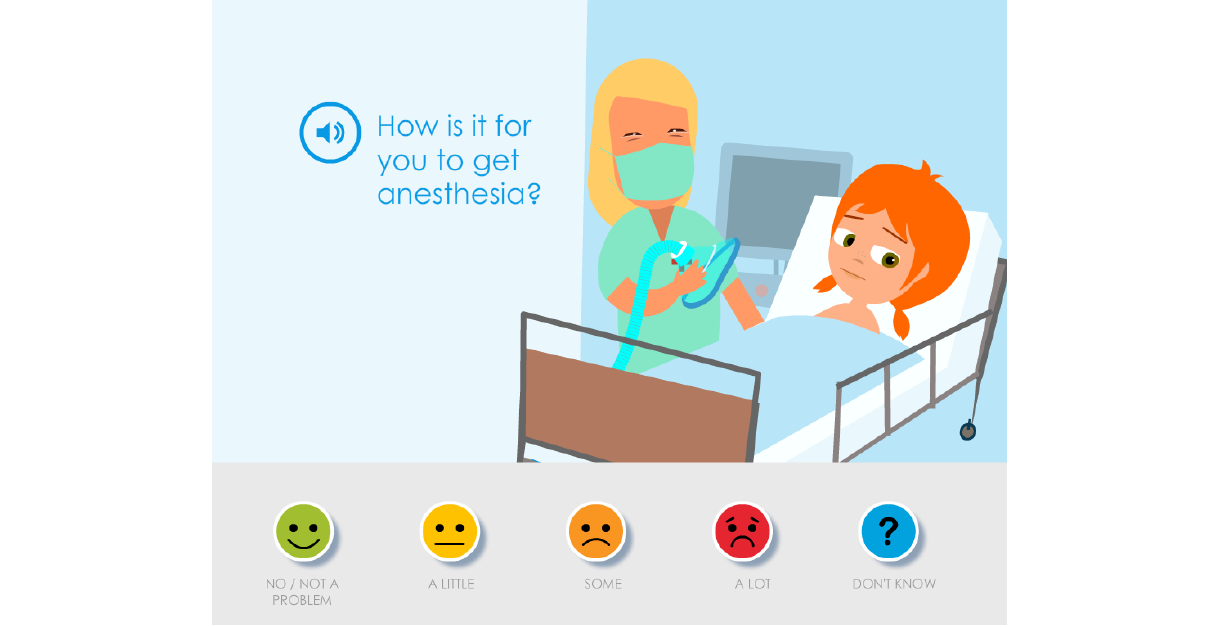
Figure 4. The picture shows the final outcome based on the children’s and parents’ suggestions that there should only be a single assessment item in a